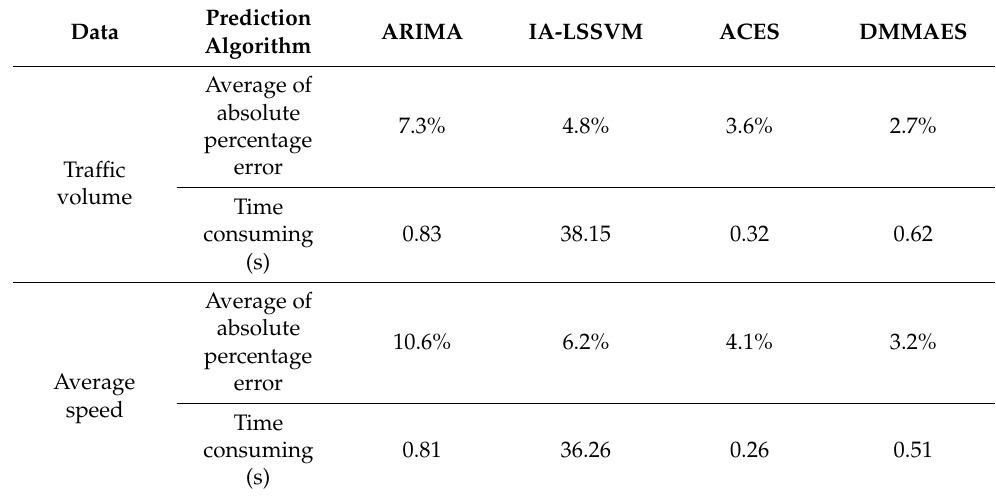
Table 3. Comparison of prediction errors and the time consumption of the four algorithms.